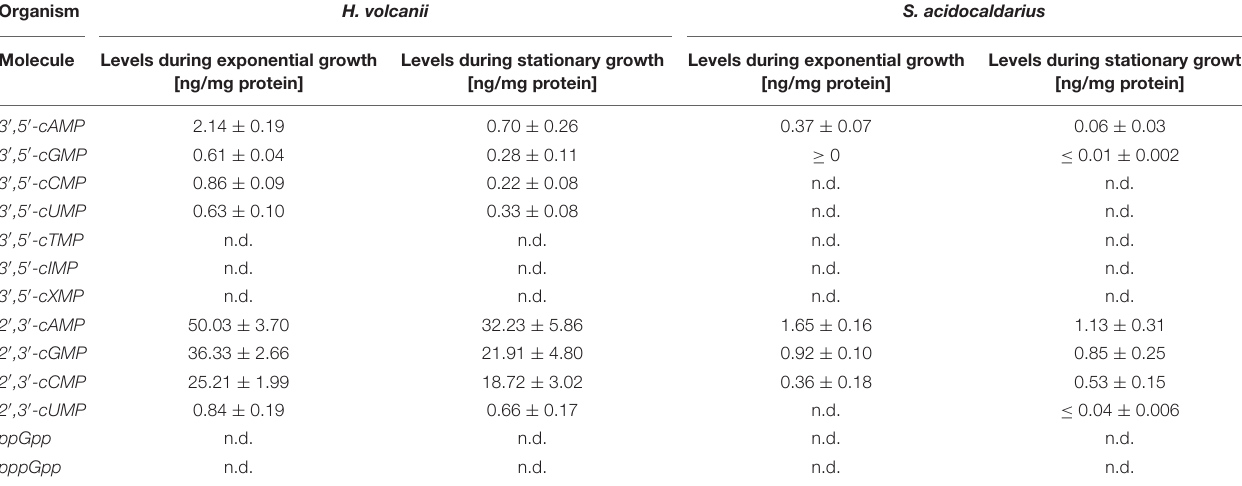
TABLE 2 | Summary of measured and detected mono-nucleotide-based (putative) second messengers. Organism H.